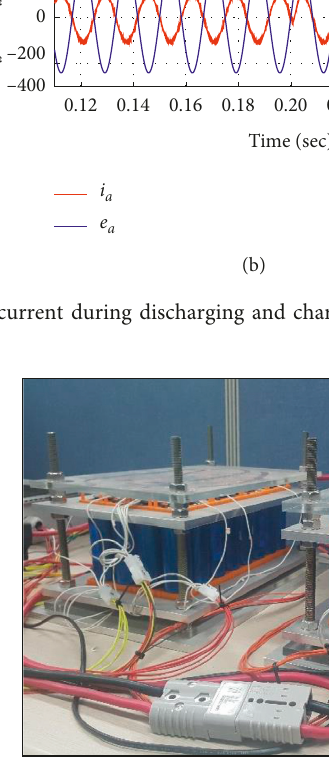
Figure 12: Lithium iron phosphate (LiFePO4) battery range, i.e., raise the value of µ and repeat the procedure from Step 3. Step 6: After the closed-loop system becomes stable, then apply the outer-loop control for CC or CV. In this paper, a synchronous reference frame phase- locked loop (PLL) is used to estimate the frequency and phase angle of the grid voltage [22]. The control structure of the conventional PLL is shown in Figure 6.